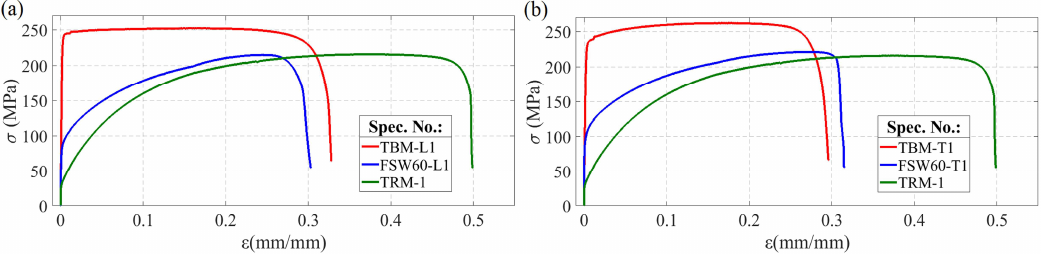
Figure 12. Comparison of representative tensile curves of base material (TBM), annealed material (TRM) and FSW specimens welded with V = 60 mm / min (FSW60): ( a ) orientation L; ( b ) orientation T.